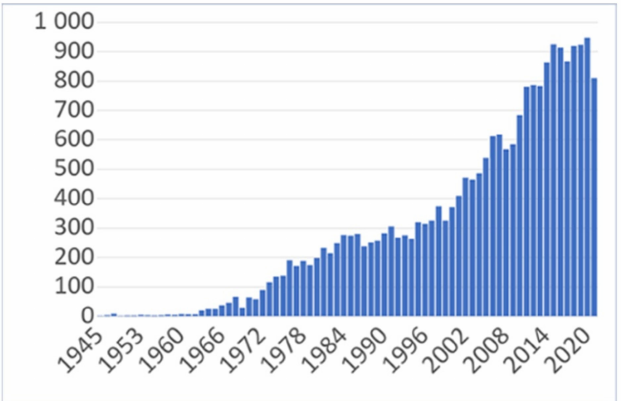
Figure 1. The evolution of interest regarding paracetamol’s hypothermic and antipyretic effects as reflected in the number of articles published and indexed in PubMed between 1945 and